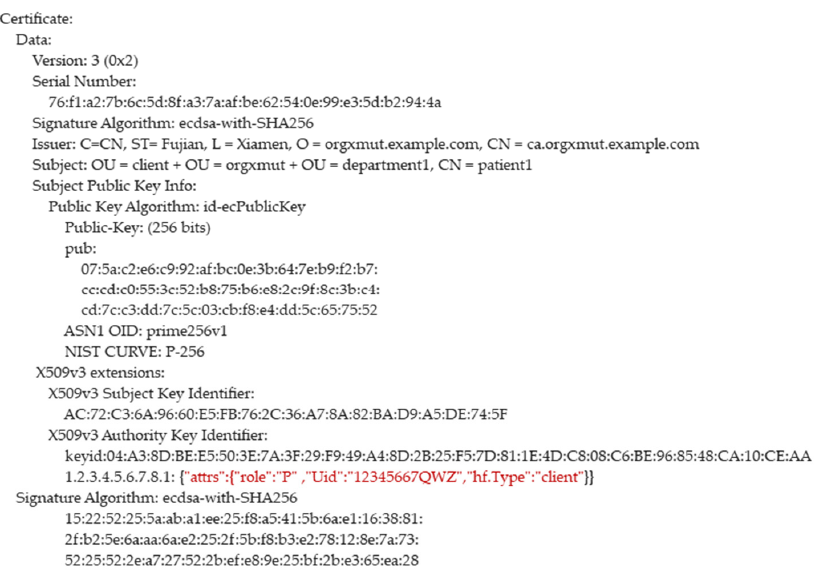
Figure 4. The example of a user’s digital certificate.